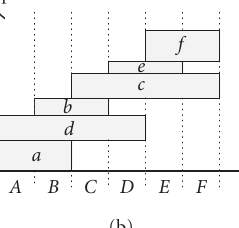
Figure 17displays the main procedure, ASSIGN MAIN,